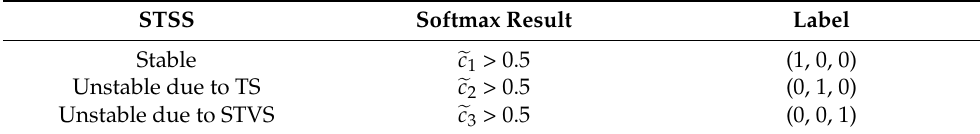
Table 1. Multiclass classifier results of